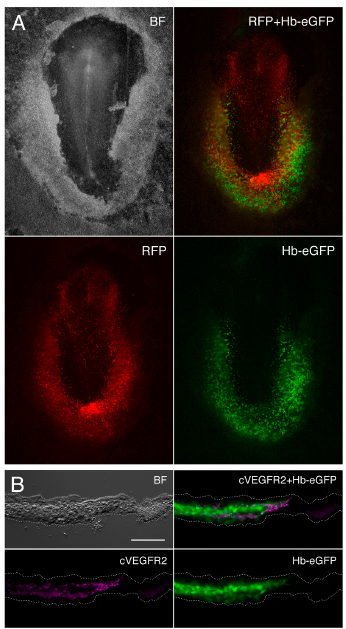
Figure 1. Expression of the yolk sac hemangioblast reporter in the early chick embryo (HH5). ( A ) Chick embryo co-electroporated with the pCAGGS-RFP ubiquitous reporter (red) and the Hb-eGFP hemangioblast reporter (green); ( B ) Transverse section of an Hb-eGFP-electroporated embryo immunolabeled for cVEGFR2 (magenta). At this early stage, the Hb-eGFP reporter specifically labels the yolk sac population of hemangioblasts, which can be identified by the expression of cVEGFR2 ( B ). This membrane receptor is detected at the surface of the eGFP-expressing cells. BF, bright field. Scale bar: 100 µ